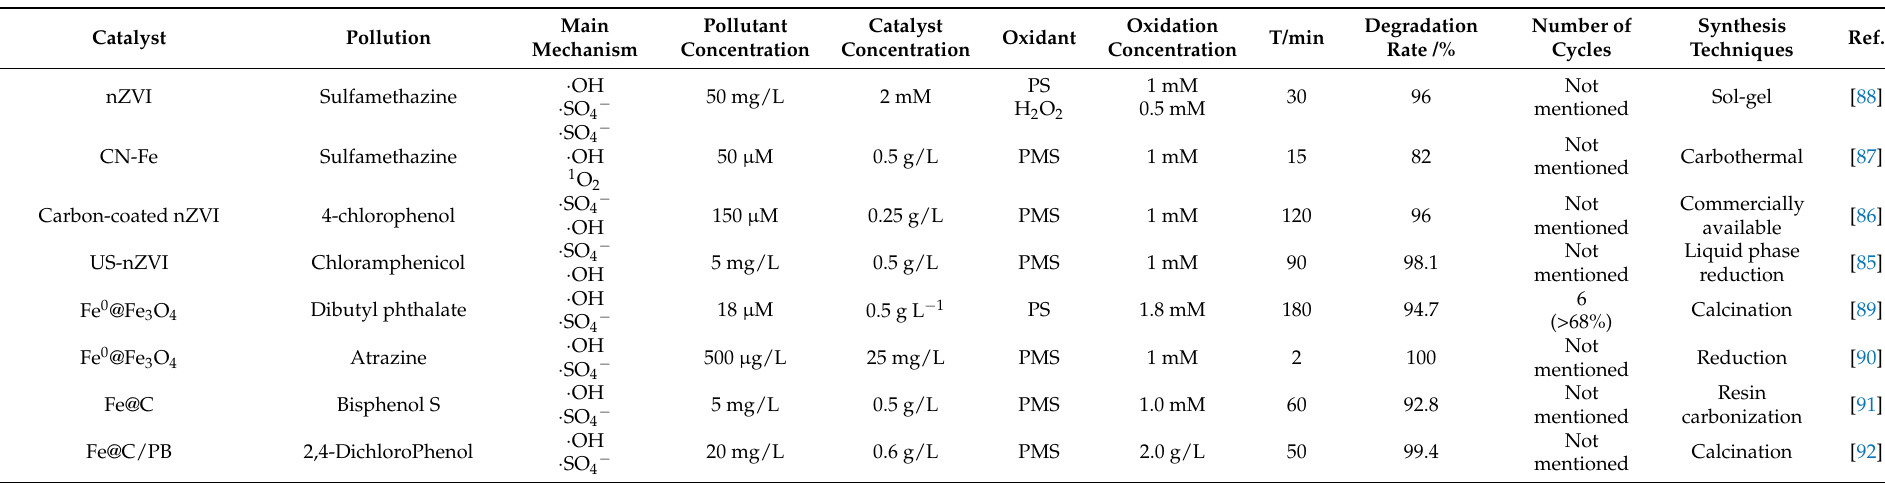
Table 3. Degradation effect of different kinds of wastewater based on PS/PMS activated by different kinds of iron